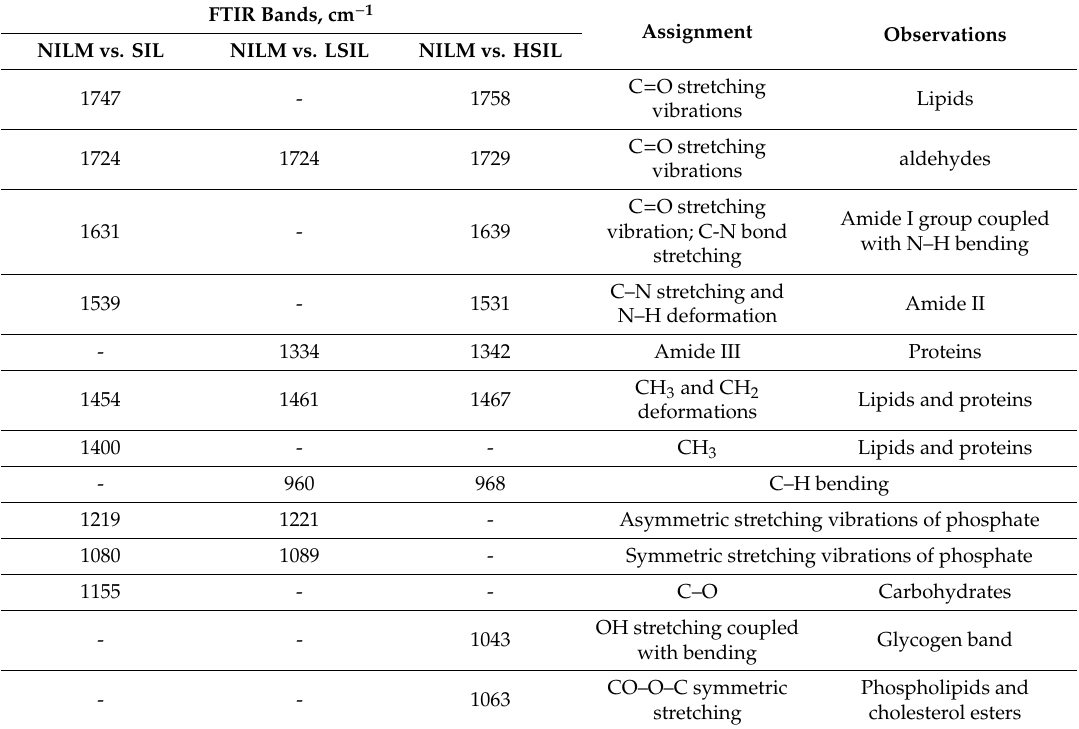
Assignment Observations